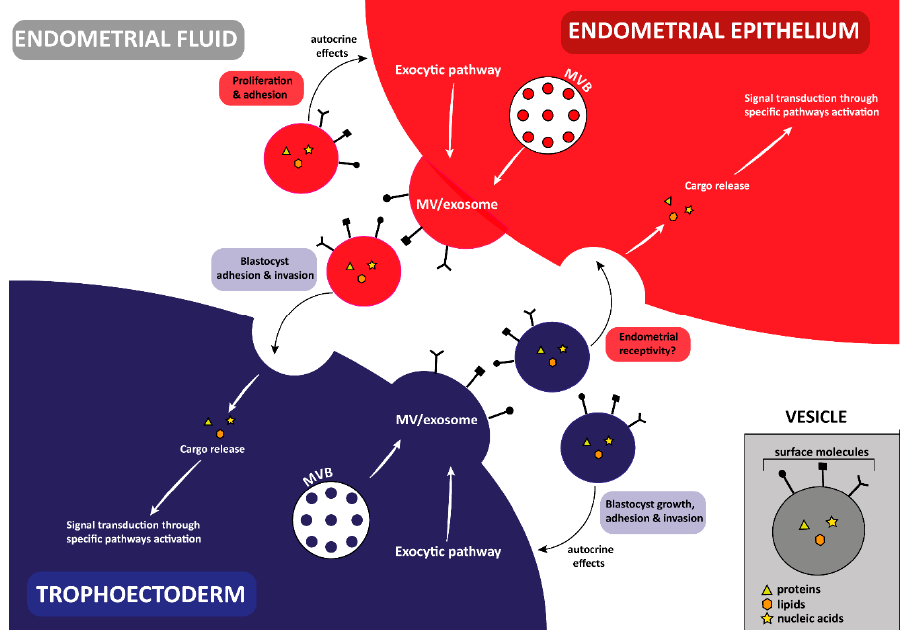
Figure 4. An overview of the involvement of exosomes and microvesicles (MV) in the cross-talk established between the endometrial epithelium and the trophoectoderm, probably mediated by the endometrial fluid. Released vesicles are represented with the same color of the donor cell, and the effect on the recipient cell is indicated in the colored-boxes.